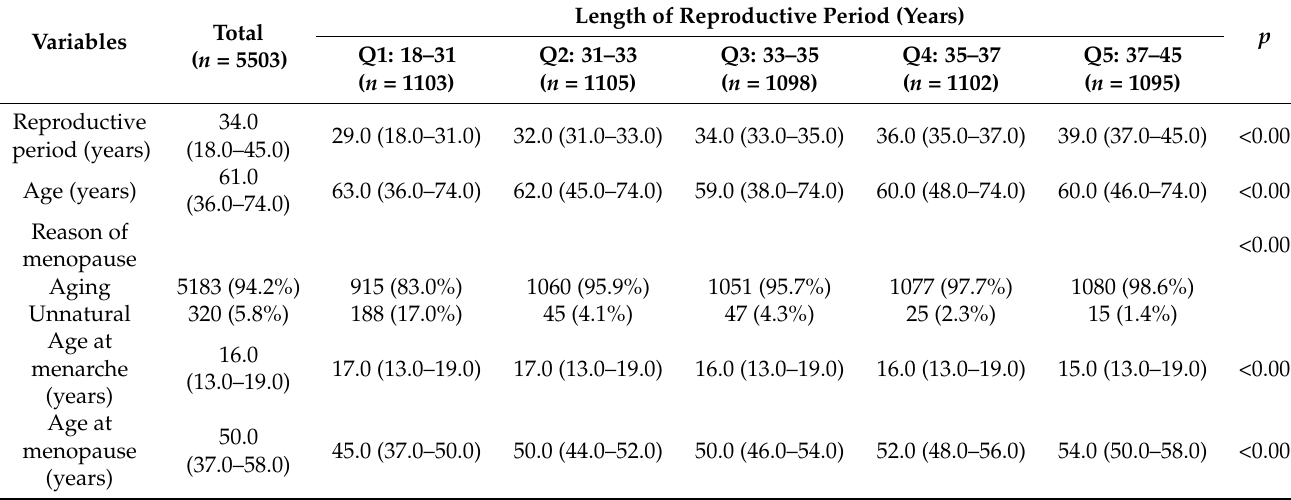
Table 1. Comparison of baseline characteristics of postmenopausal women with different length reproductive period.